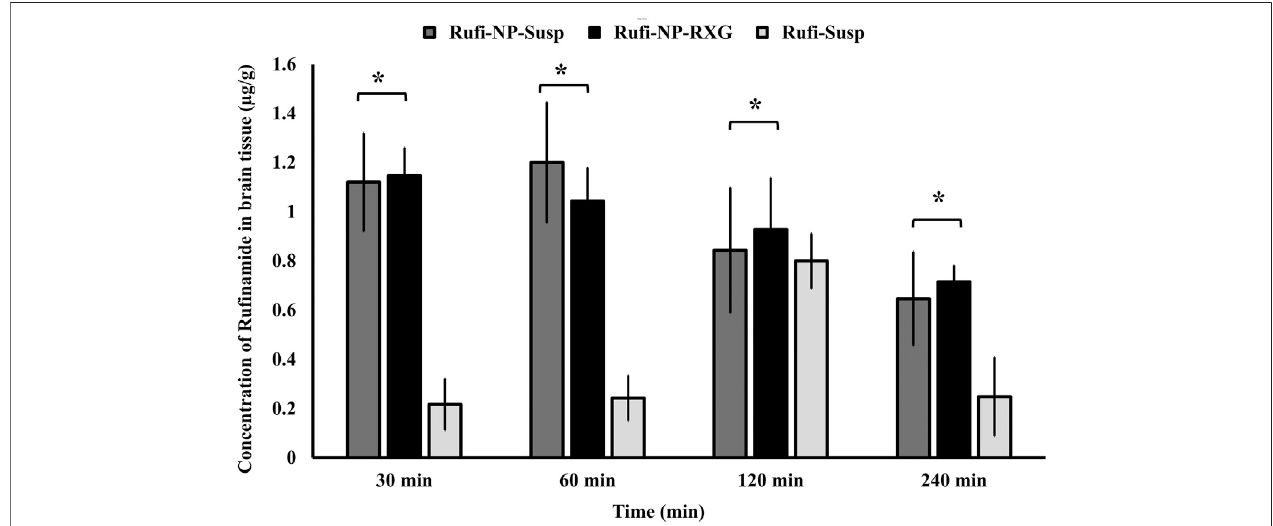
FIGURE6| Comparison ofconcentrationofRu fi namide inbrainfollowingintranasal administration ofRu fi -NP-Susp,Ru fi -NP-RXG,and Ru fi -Susp. Note: Each bar representsmean ± SDofbrainconcentrationsofn (cid:2) 4rats;Statisticallynosigni fi cantdifferenceunlessmentionedotherwise;allstatisticaltestswereperformedfordose- normalized concentrations using t -test at α (cid:2)